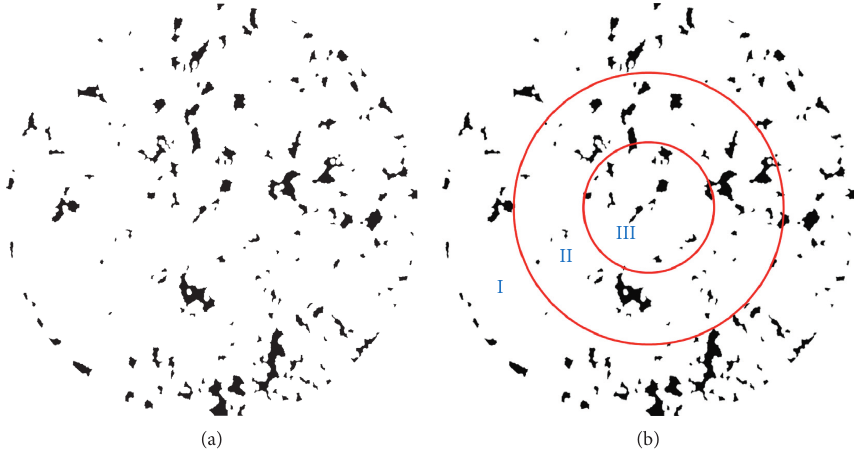
Figure 4: Air voids extraction in different layers. (a) Image binarization. (b) Three layers in a PAM slice.